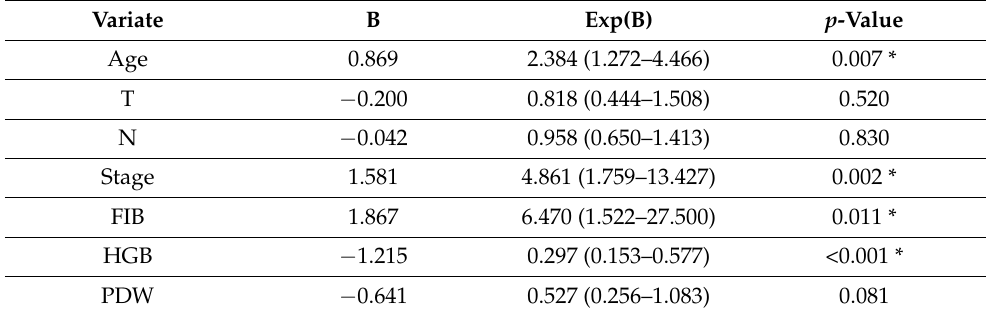
Table 2. Multivariate COX regression of demographic factors and peripheral parameters for OS in all advanced LSCC patients.